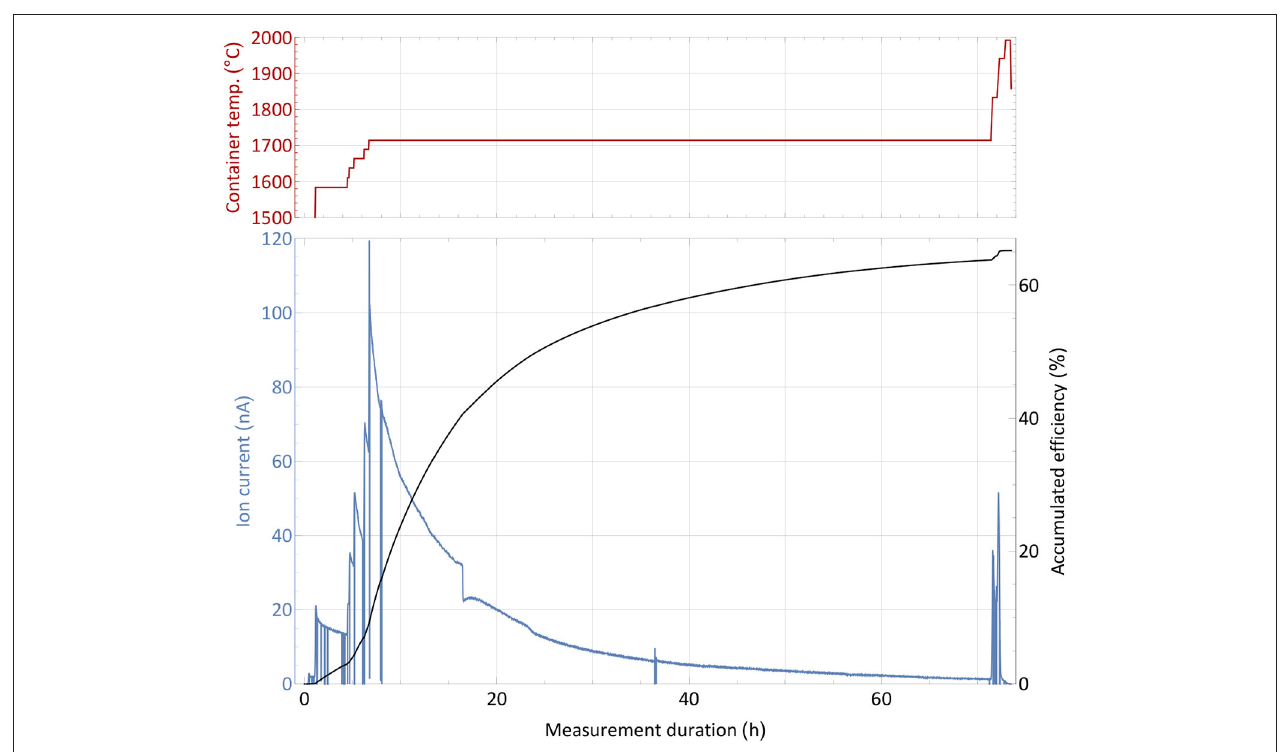
FIGURE 2 | Overall efficiency determination measurement with a 1,590nAh stable 169 Tm sample. The extracted ion current is shown with respect to the sample container temperature (top panel) over time. Additionally, the accumulated efficiency (i.e., the ratio of collected atoms to the initial sample amount) is given for every time